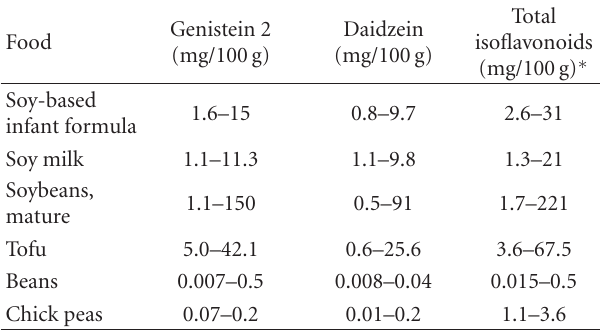
Table 1: Isoflavonoid content of selected legumes and soy-based foods